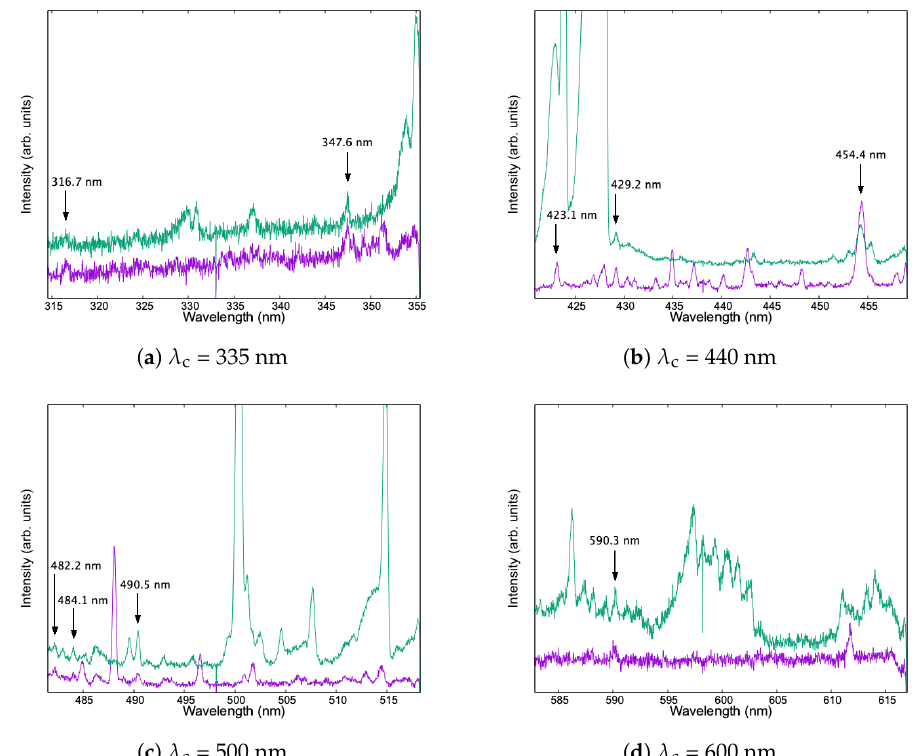
Figure 1. Visible emission spectra of radiation resulting from the collisions of Er 4 + ions with Ar (purple) and N 2 (green) targets at an energy of 60 keV.